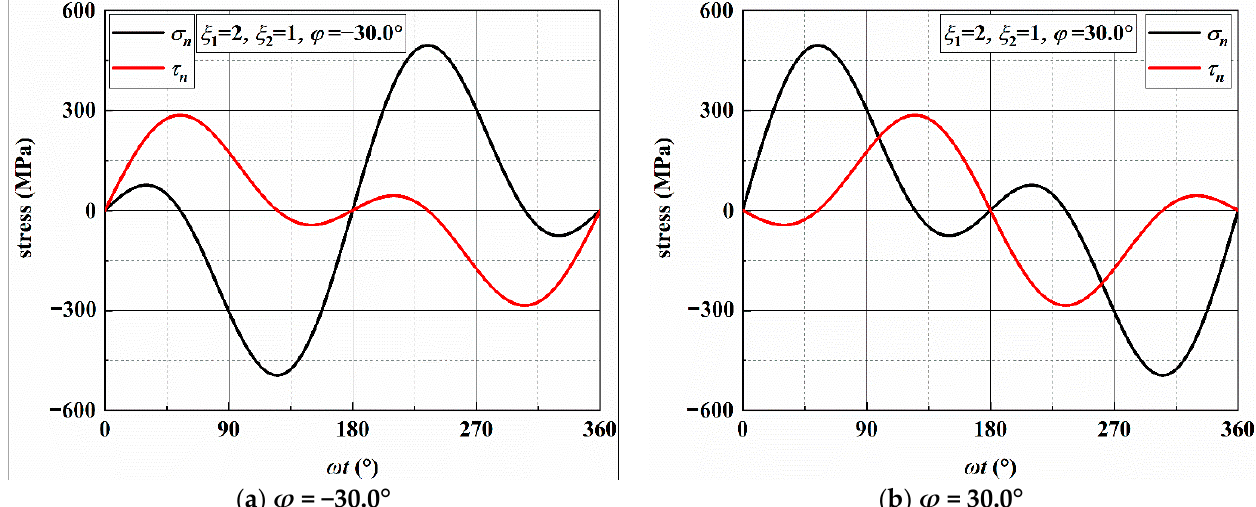
Figure 7. Variation in stresses on the MN plane under AS-1.